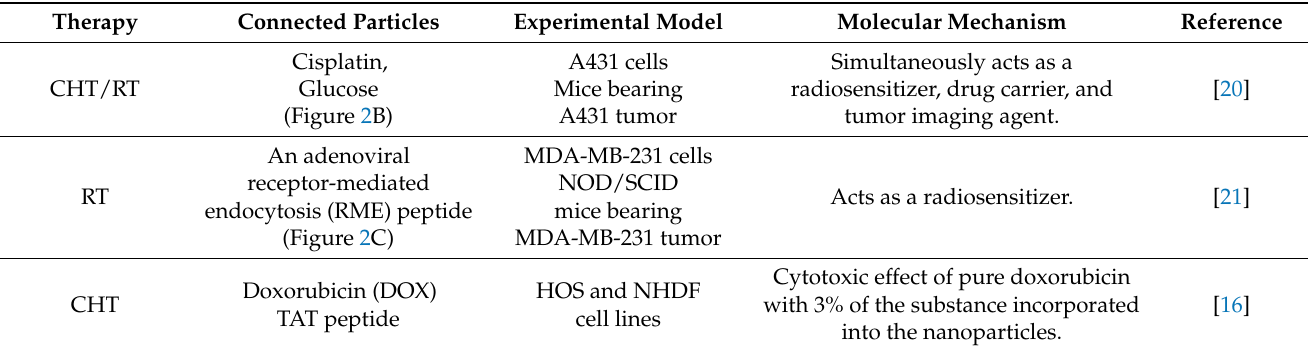
Table 1. Selected connections of biologically active molecules with gold